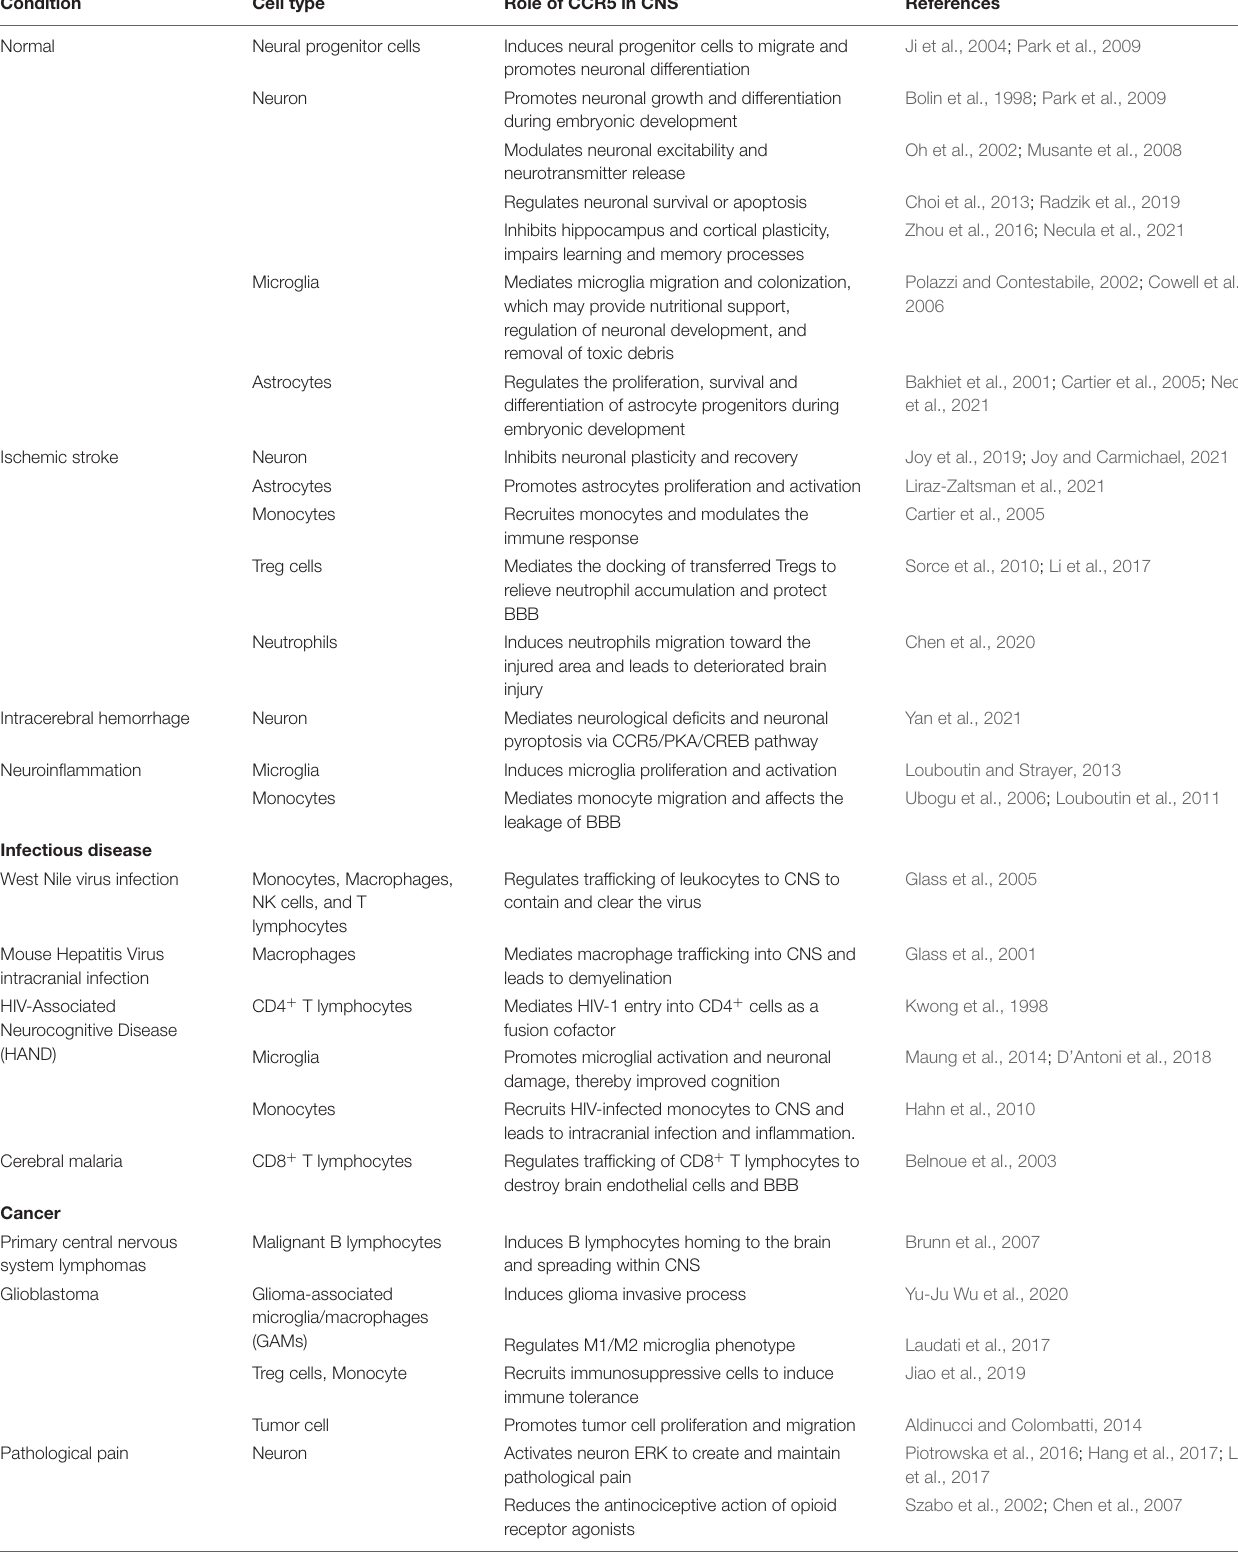
TABLE 2 | Various roles of CCR5 in the CNS during healthy and diseased states.